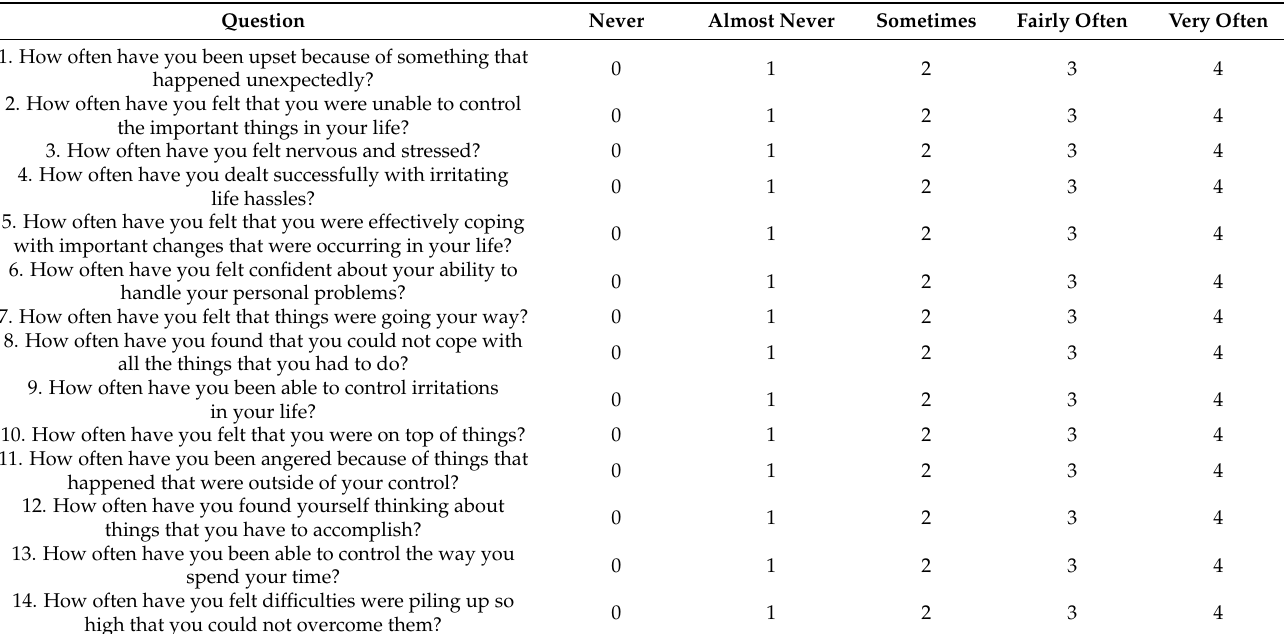
Table 4. Perceived Stress Scale,